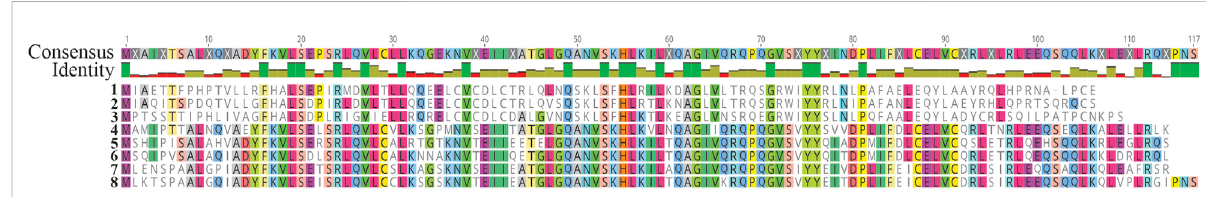
FIGURE 4 Alignmentofproteinsequencescodedbythegene smt Boftherepresentativecyanobacterialspecies.1:SmtB1of Synechococcus sp.UCP002, 2: smtB1 of Synechococcus sp. PCC 6312 (WP_015123347), 3: smtB of Calothrix sp. PCC 7507 (WP_01512714), 4: smtB2 of Synechococcus sp. UCP002, 5: smtB of Leptolyngbya sp. PCC 6406 (WP_008314625), 6: smtB of Oscillatoria nigro-viridis (WP_01574920), 7: smtB of Nostoc sp. PCC 7107 (WP_015114276), and 8: smtB of Anabaena sp. PCC 7108 (WP_016952607). The alignment was conducted using the Alignment tool of Geneious Prime ®